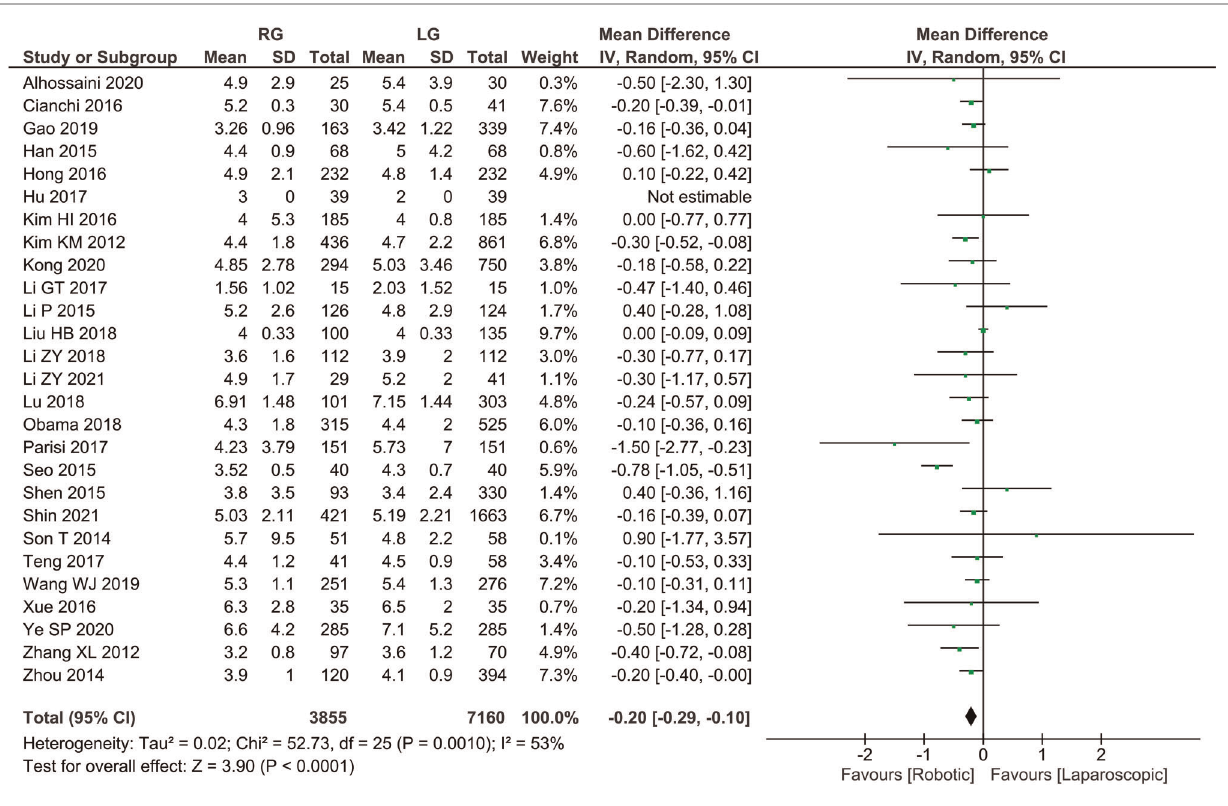
FIGURE 5 | Comparison of time to fi rst postoperative food intake between RG and LG